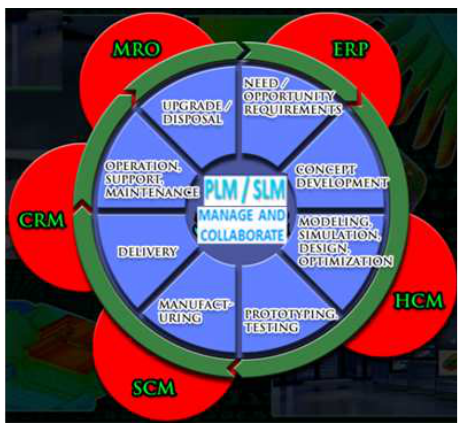
Figure 1. Product Lifecycle Activities.